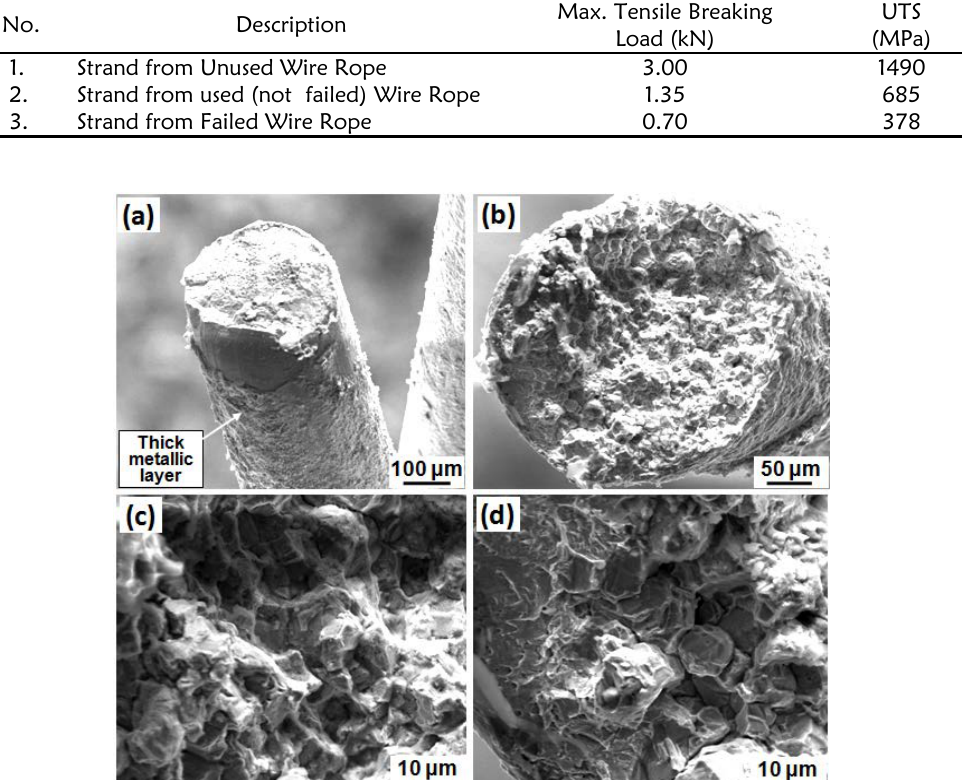
Table 2: Tensile properties of the strands for unused, used (not failed) and failed wire ropes. Sl. No.